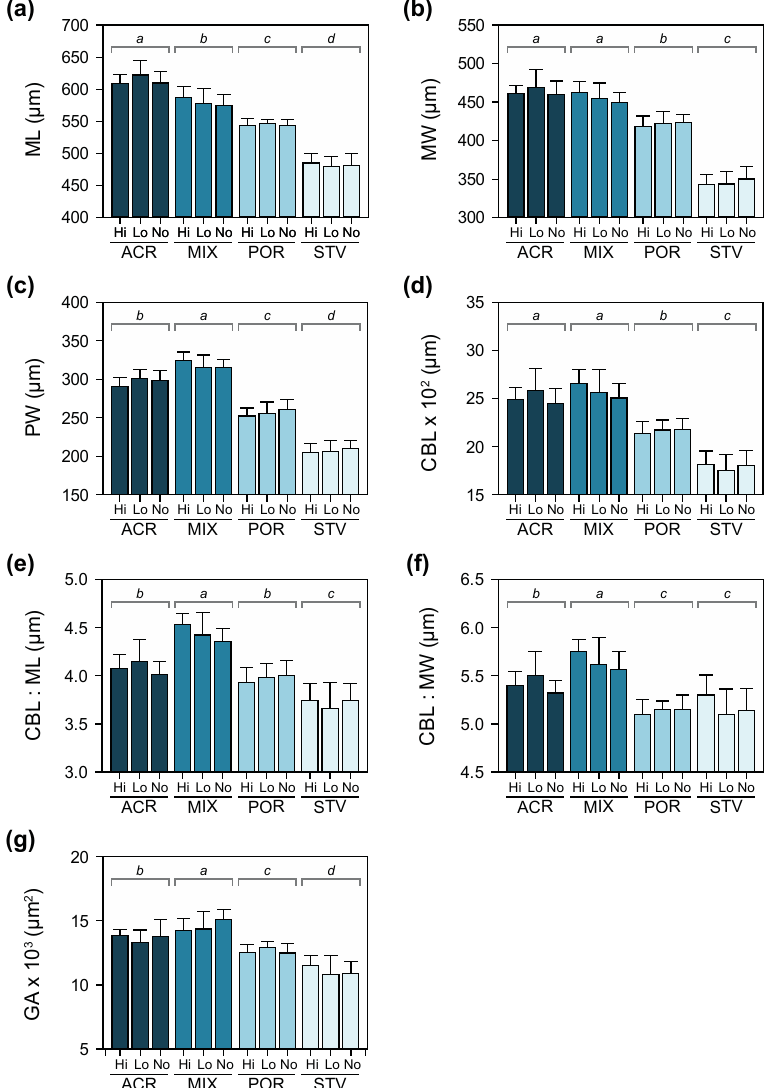
Figure 5. Morphometric measurements of larvae (± SD) at Day 4: ( a ) maximum length ( ML ), ( b ) maximum width ( MW ), ( c ) posterior width ( PW ), ( d ) ciliated band length ( CBL ), ( e ) ratio of CBL to ML , ( f ) ratio of CBL to MW , and ( g ) gut area ( GA ). Letters above bars denote significant differences as determined by Tukey’s post hoc tests following two-way ANOVA.